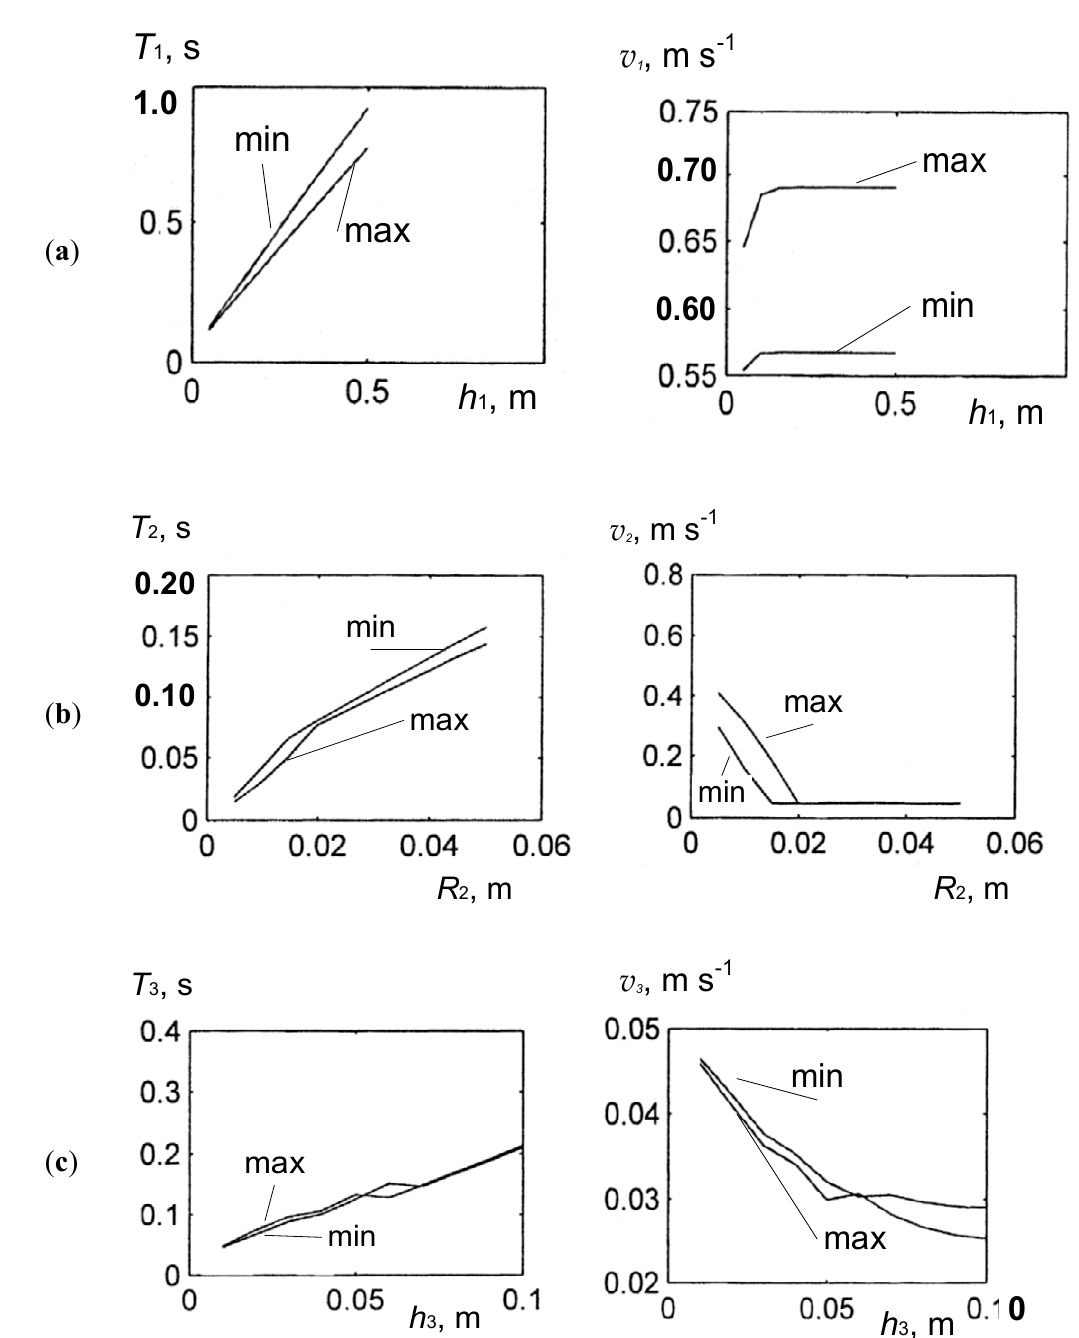
Figure 2. Influence of the height of the seed pipe h 1 in zone I ( a ), the radius of curvature R of the seed pipe in zone II ( b ), and the height h 3 of the seed fall in zone III ( c ) on the time ( T 1 , T 2 , and T 3 ) and speed ( v 1 , v 2 , and v 3 ) of the movement of a single seed. The maximum (max) line is for the maximum size and weight parameters of the pine seed (the single seed mass m max = 8.0 × 10 − 6 kg; the square of seed midsection S S = 8.5 × 10 − 6 m 2 ), the minimum (min) line is for the minimum values ( m min = 5.6 × 10 − 6 kg; S S = 3.2 × 10 − 6 m 2 ). The height h and radius R of the pipeline are limited to 0.5 m and 0.1 m due to compliance with the requirements for small dimensions of the